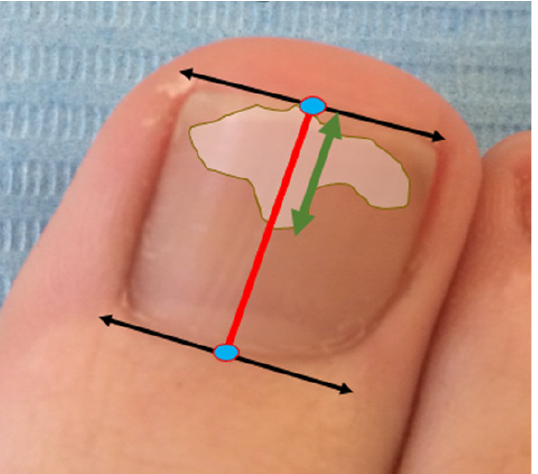
Figure 1. Affected percentage of the longitudinal axis of the nail. The middle point (blue dots), the nail width (black arrow) at the onychocorneal band, and the hyponychium level were calculated. These two points were combined to define the longitudinal axis of the nail (red line). The shaded area simulates the nail lesion. The total length and the affected part of the longitudinal axis were measured (green arrow).